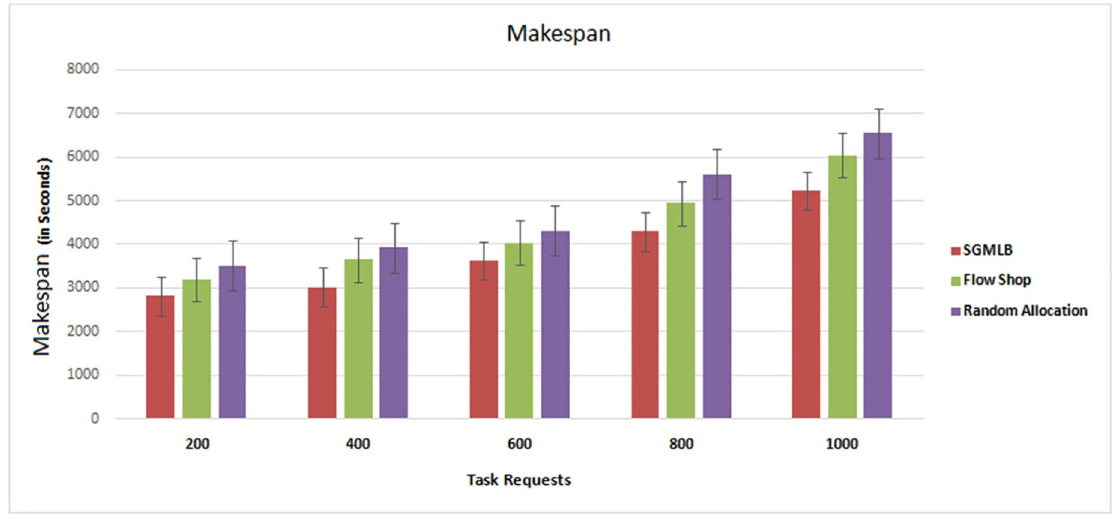
Fig 3. Makespan analysis.